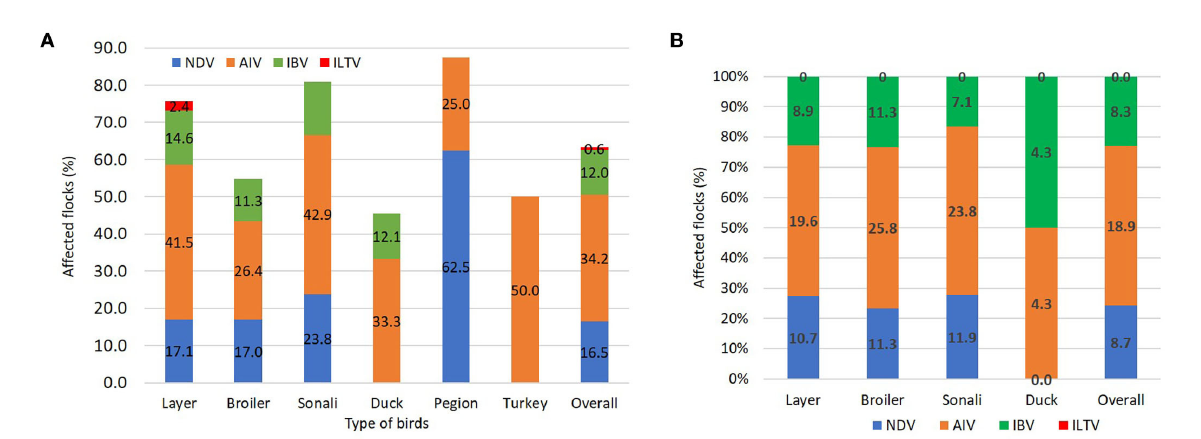
FIGURE3 Detection of respiratory pathogens by applying the multitarget simultaneous RT-qPCRs. (A) The stacked column showing the percentage of respiratory pathogens in tissue samples among different bird types. (B) The stacked column showing the percentage of respiratory pathogens in oropharyngeal swab samples among different bird types.